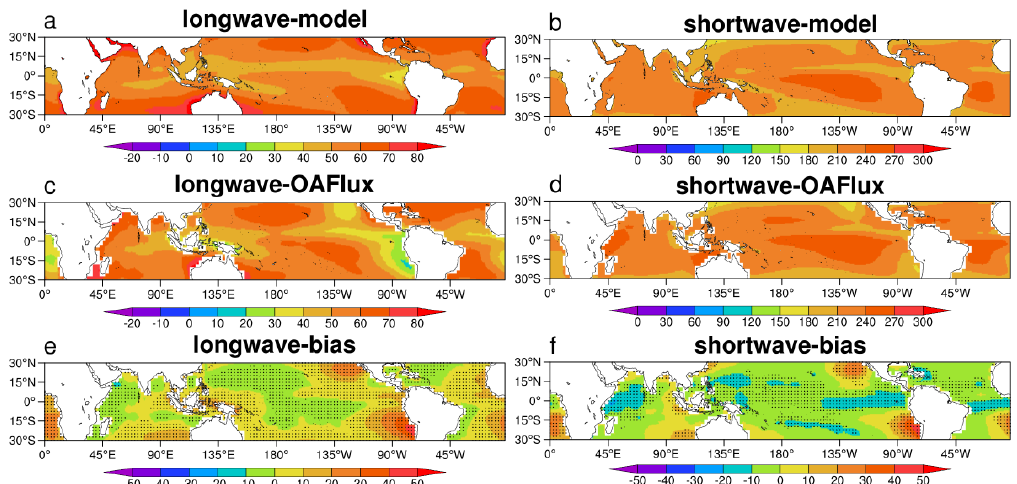
Figure 2. (left) Climatological average of the Q LW from ( a ) model ensemble, ( c ) OAFlux and ( e ) model ensemble minus OAFlux. Right panels are for Q SW . Dotted areas in the bottom panels indicate where the bias is statistically significant at the 95% level based on a Student’s t -test. (unit: W m − 2 ).